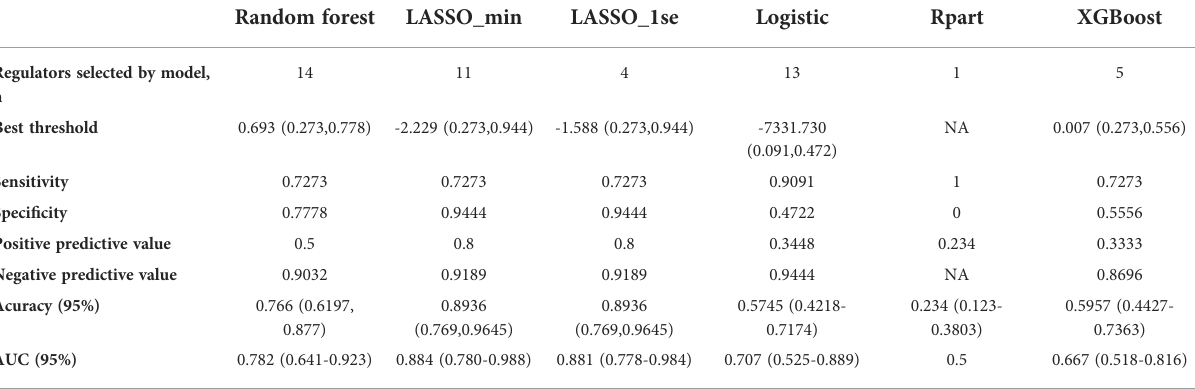
TABLE 2 Model performance of the six classi fi ers in validation set 2: A random forest wrapper (Boruta), LASSO_ l -min, LASSO_ l -1se, logistic regression, regression partition trees (Rpart) and extreme gradient boosting (XGBoost). Random forest LASSO_min LASSO_1se Logistic Rpart